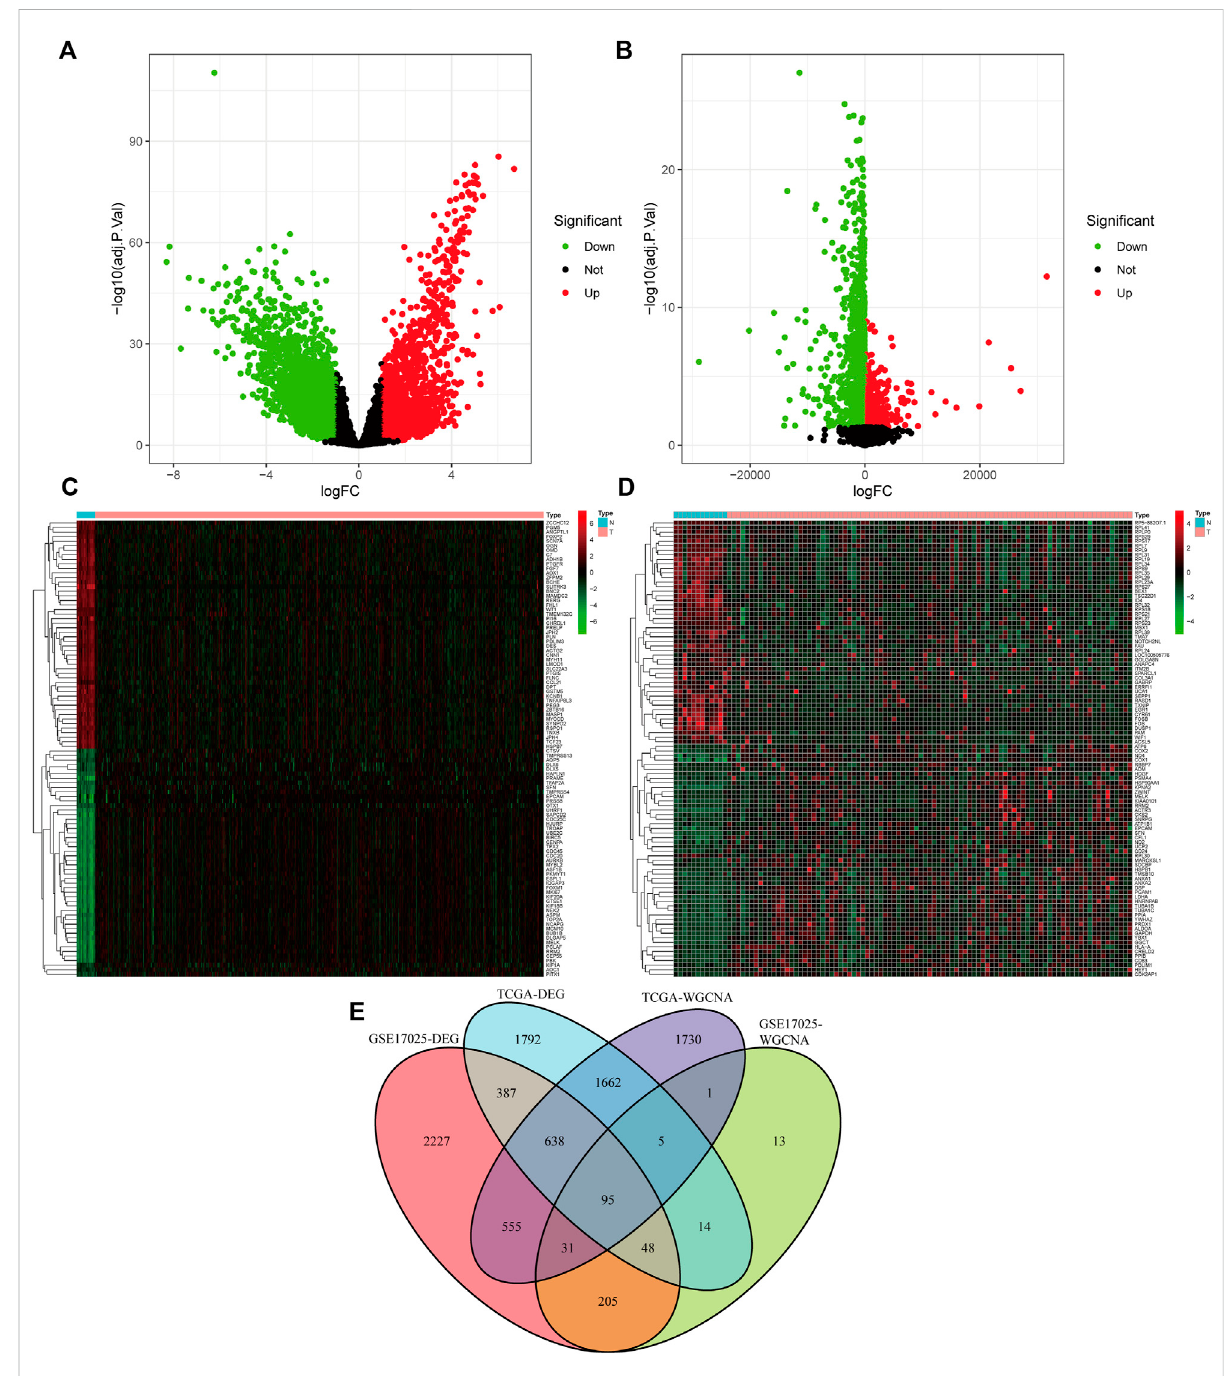
FIGURE 3 Acquiring (differentially expressed genes) DEGs and overlapping genes. (A) Volcano plot of the DEGs in TCGA-UCEC. (B) Volcano plot of the DEGsinGSE17025. (C) HeatmapoftheDEGsinTCGA-UCEC. (D) HeatmapoftheDEGsinGSE17025. (E) AVenndiagramofgenecrossoverbetween the DEGs and Weighted Gene Co-expression Network Analysis